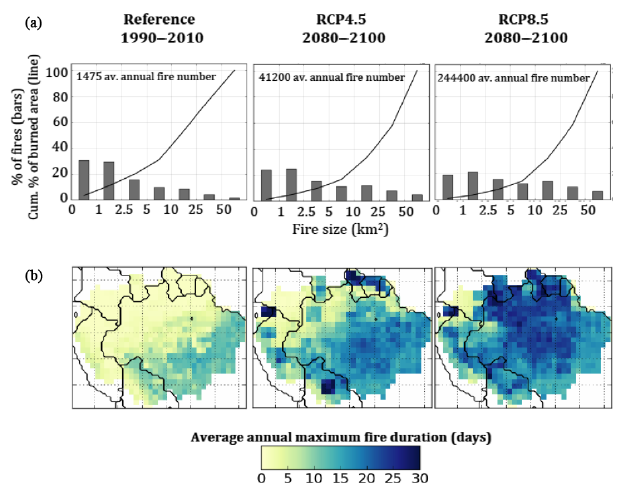
Figure 4. Mean fire size increases under both RCP4.5 and RCP8.5 climate scenarios (a) based on climate conditions that permit longer fire duration by the end of the 21st century (b) .